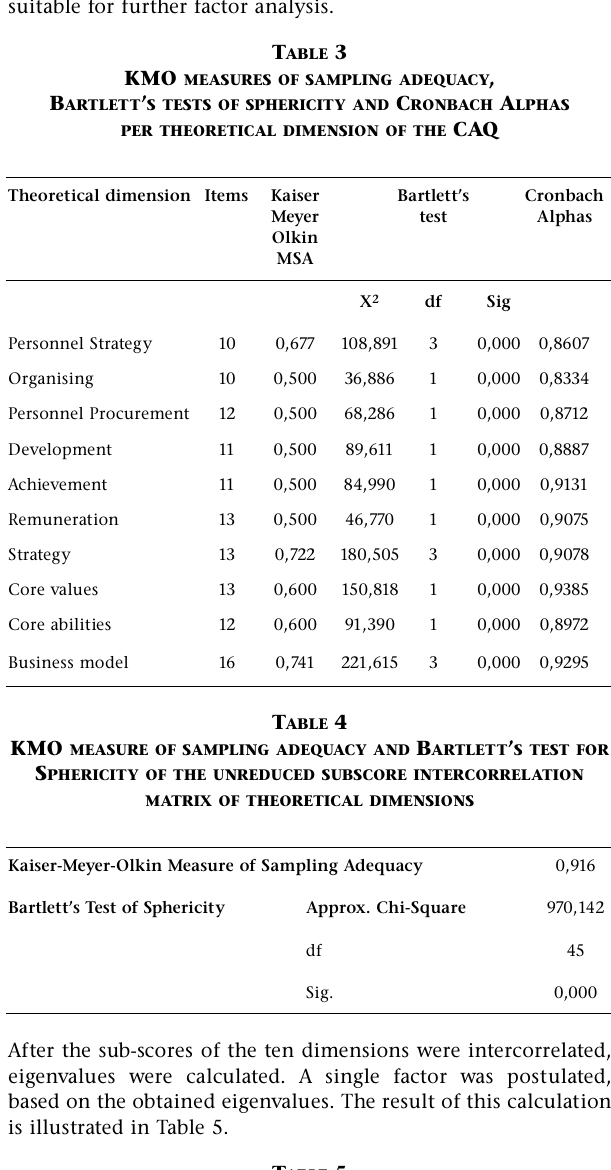
Table 6 indicates that a single factor was extracted by using Principal Axis factoring. Four iterations were required for the solution to converge. All the dimensions indicate high loadings, varying between 0,88 and 0,75 on the single extracted